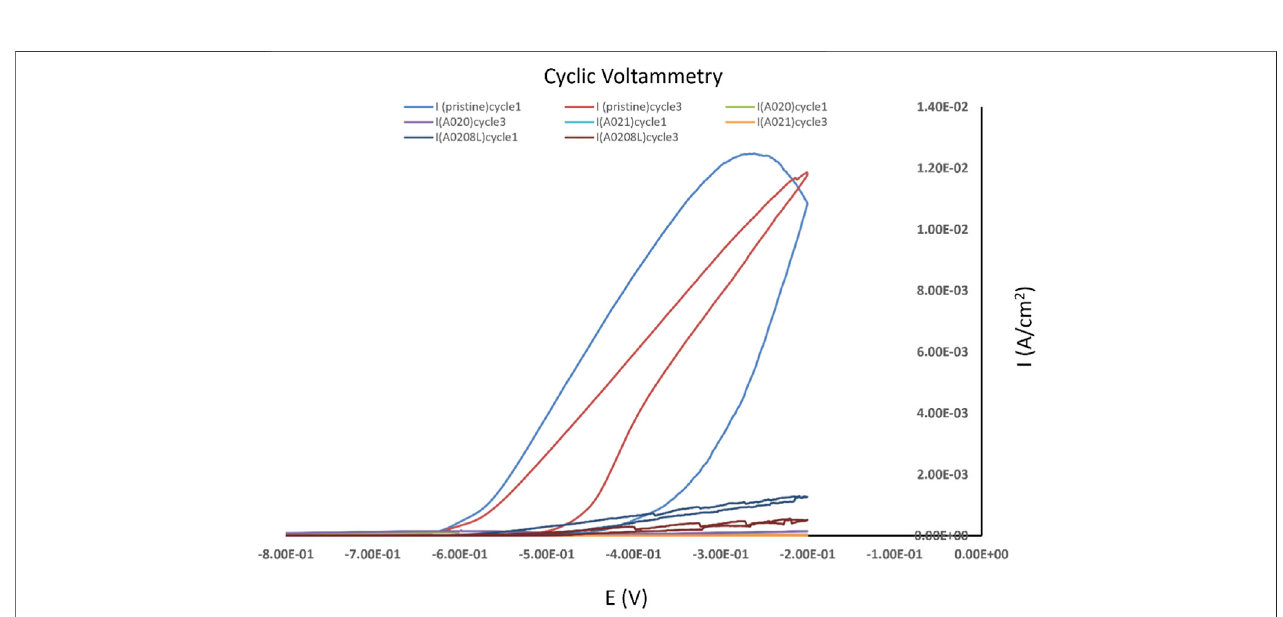
FIGURE 13 | Cyclic voltammetry measurements for pristine aluminium and with different coating matrices.